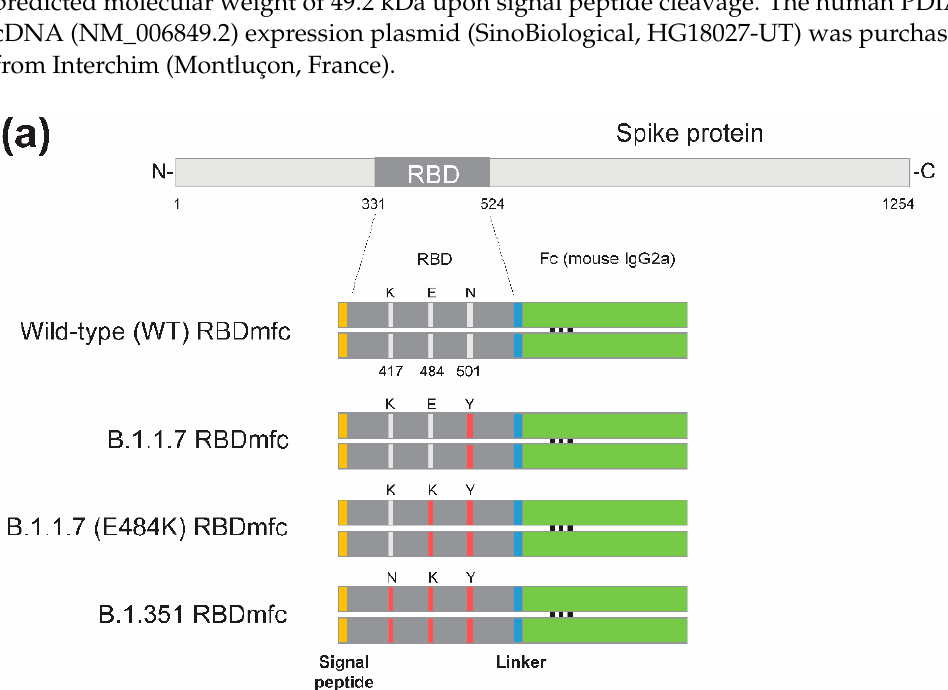
Figure 1. Expression of recombinant RBDmfc proteins in Expi293F cells. ( a ) Domain architecture of recombinant RBDmfc proteins investigated. The RBD domain (amino acids 331-524 of the spike pro- tein) of SARS-CoV-2 isolate Wuhan-Hu-1 (wild type or WT) and variants B.1.1.7, B.1.1.7 (E484K) and B.1.351 was expressed by transient transfection into the Expi293F human cell line. RBD B.1.1.7 carries a single mutation (N501Y), RBD B.1.1.7 (E484K) two mutations (E484K and N501Y) and B.1.351 three mutations (K417N, E484K and N501Y) (shown in red). The respective RBD domains were expressed in fusion with an N-terminal optimised signal peptide to allow protein secretion and a C-terminal mouse IgG2a Fc fragment to facilitate purification on protein A affinity resin and to produce Y-shaped protein dimers. RBDmfc proteins are produced as dimers linked by disulphide bonds between their Fc fragments. One RBDmfc monomer is 437 amino acids long and has a pre- dicted molecular weight of 49.2 kDa (upon cleavage of the signal peptide). ( b ) Concentration of RBDmfc proteins secreted in the culture medium of Expi293F cells, measured by Octet RED96 and expressed in μ g/mL culture. Values are mean (standard deviation) of two independent experiments. RBD mutants carrying the E484K mutation were expressed at lower levels in the medium of Expi293F cells. The level of secreted B.1.351 RBDmfc was 27% that of WT RBDmfc. By contrast, mutation N501Y had no impact on the secreted protein production yield. 2.1.2. Plasmid Production and Purification Plasmids were transformed into One Shot TOP10 Chemically Competent E. coli (ThermoFisher Scientific, Carlsbad, CA, USA; C404010) with the rapid chemical transfor- mation procedure proposed by the manufacturer. Transformed E. coli were spread on LB